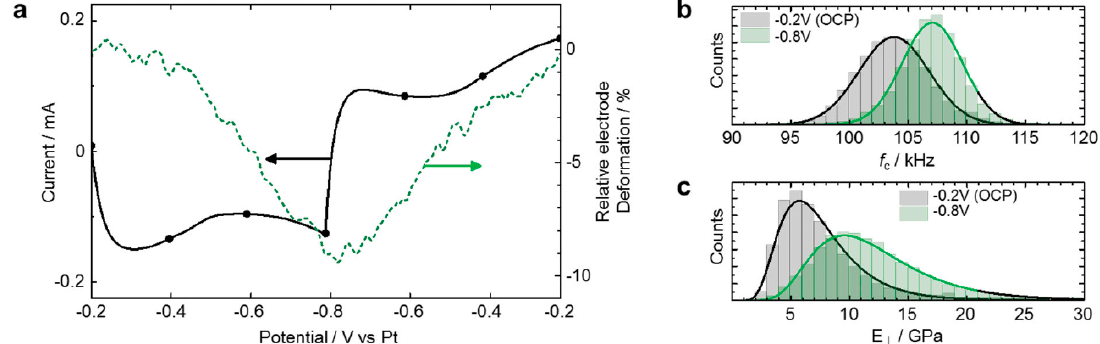
Figure 7. Elastic changes of Ti 3 C 2 T x in Li 2 SO 4 electrolyte. ( a ) Electrochemical profile of Li + intercalation / extraction showing the current and single point relative electrode deformation profiles as a function of potential. ( b ) Frequency distribution histograms at charged and discharged states. ( c ) Corresponding elastic modulus distribution histograms. Reproduced with permission from [59]. Copyright John Wiley & Sons,